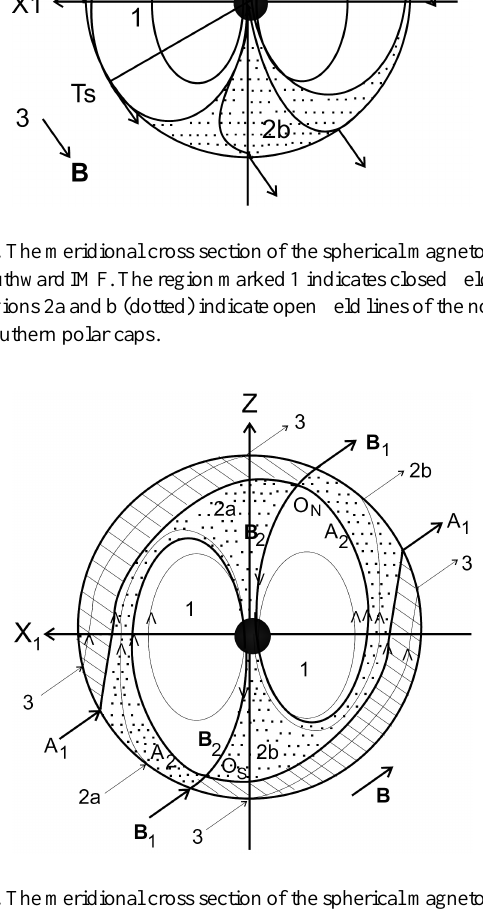
Fig. 2. The meridional cross section of the spherical magnetosphere for northward IMF. The region marked 1 indicates closed field lines, the regions 2a and b (dotted) indicate open field lines of the northern and southern polar caps, the shaded region indicate interplanetary magnetic field lines inside the